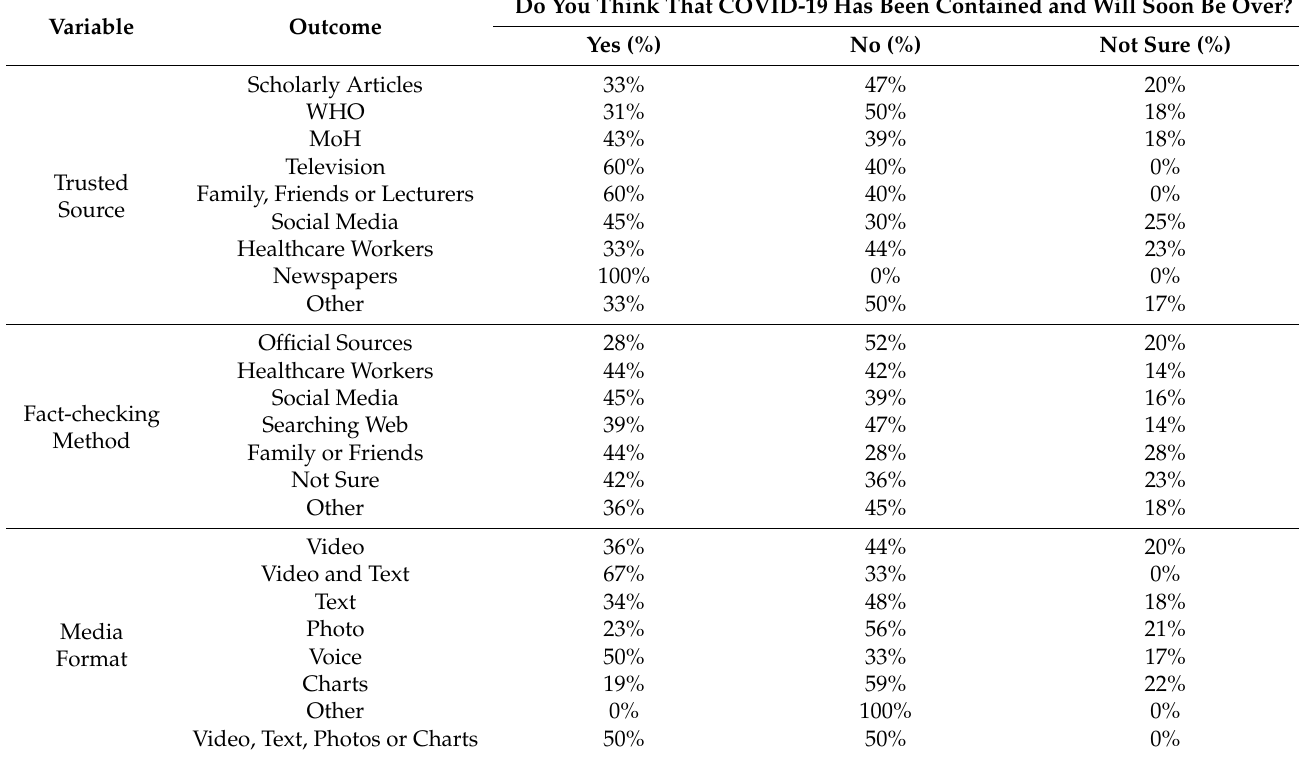
Table 7. Information-seeking strategies and attitudes towards COVID-19 among Palestinian students, May 2020. ( n = 951). Do You Think That COVID-19 Has Been Contained and Will Soon Be Over? Variable Outcome Yes (%) No (%) Not Sure (%)